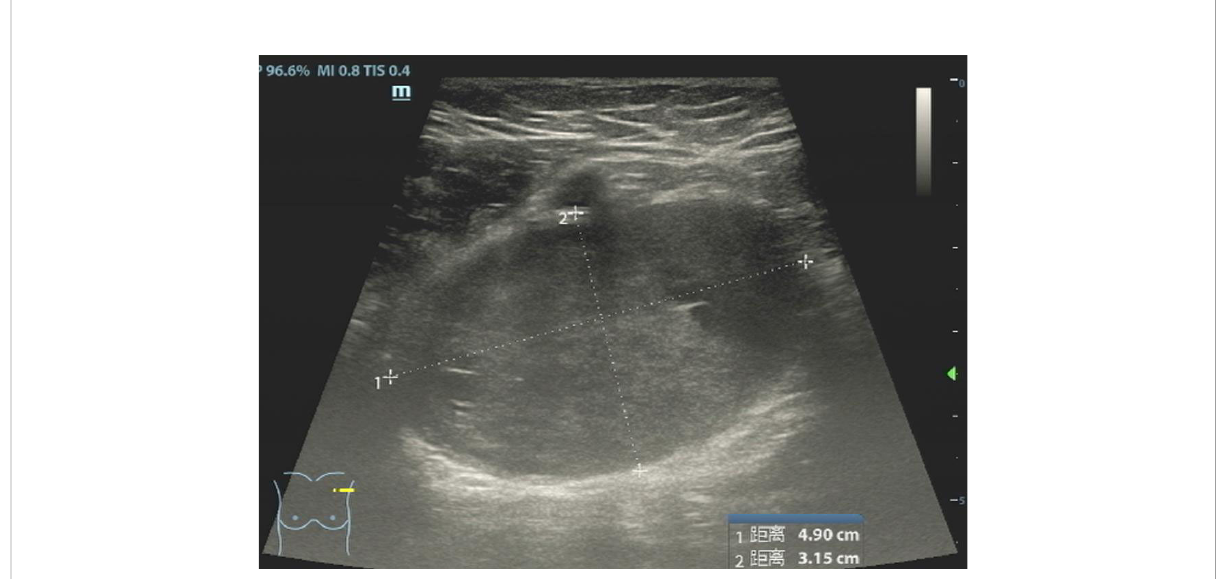
FIGURE 1 Ultrasound of the left axillary area showed a solid mass with two small cystic degenerations, which were highly suspected to be a few lique fi ed abnormal structures in the lymph